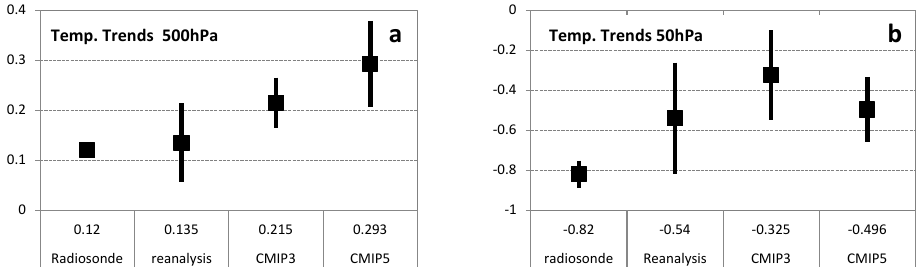
Fig. 2. The global mean temperature trends ( ◦ Cdecade − 1 ) and standard deviations for the four data groups in the period of 1979–2005. (a) 500hPa; (b) 50hPa.